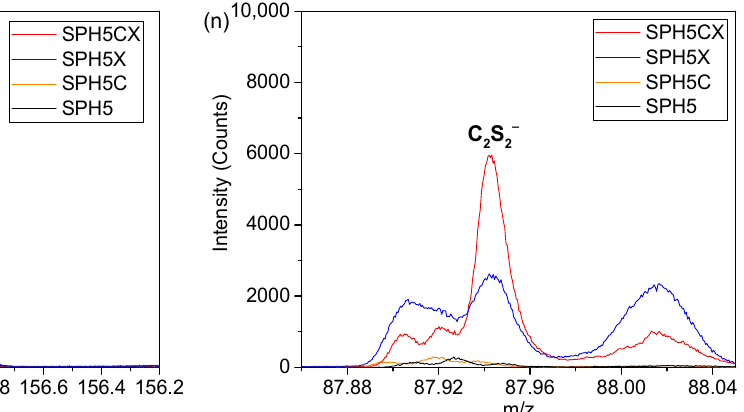
Figure 3. Time-of-flight secondary ion mass spectrometry (ToF-SIMS) spectra of marmatite (SPH5) at pH 6.5: ( a – e ) positive-ion mass spectra and ( f – n ) negative-ion mass spectra. The red line is the mass spectra of Cu-activated marmatite surface after BX absorption; the blue line is the mass spectra of BX absorbed marmatite surface; and the orange line is the mass spectra of the Cu-activated marmatite surface; the black line is the mass spectra of marmatite surface.